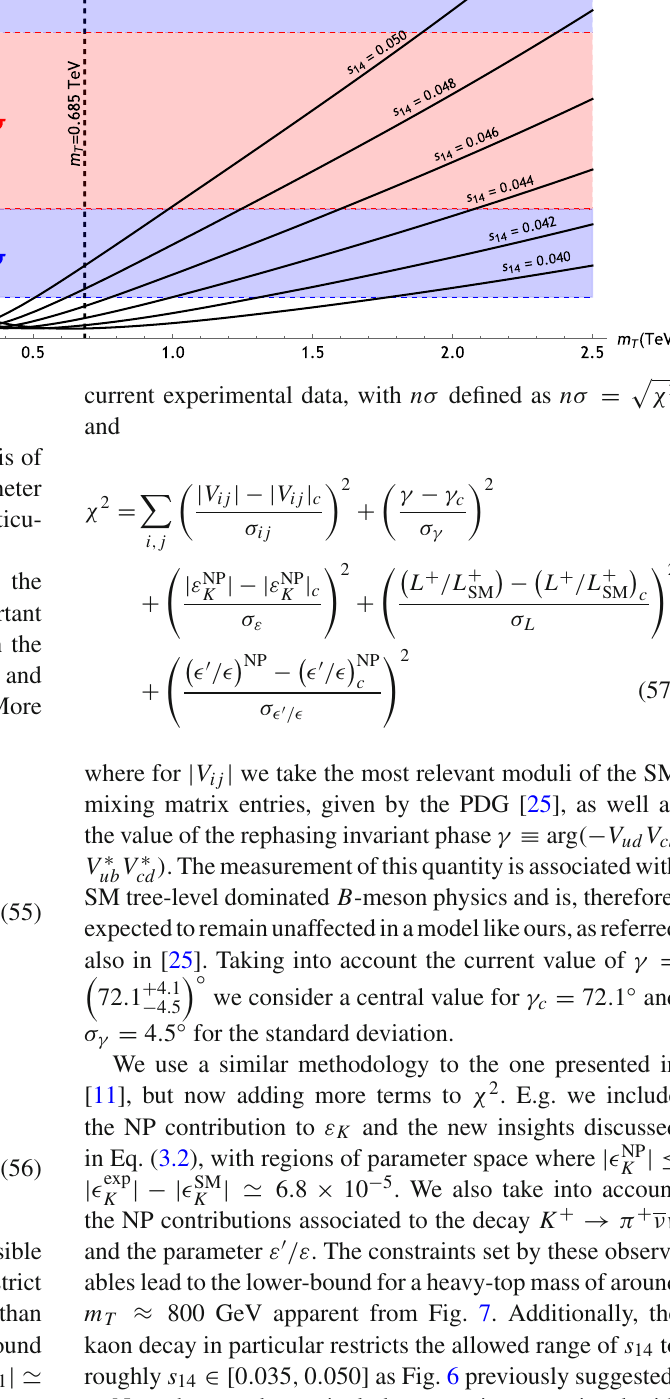
Fig. 6 Plot of Eq. (49) as a function of m T for various values of s 14 ≥ 0 . 04 with s 24 = s 34 = 5 × 10 − 4 , δ (cid:11) = 1 . 2 and using Eq. (29). The coloured regions refer to the 1 σ and 2 σ